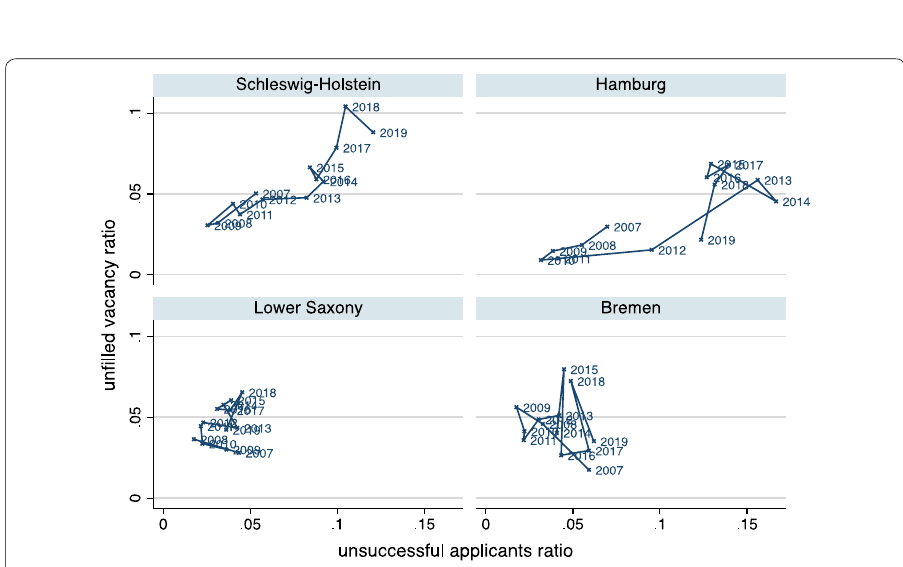
Fig. 10 Beveridge curves for North-Western German states (2007–2019). Data sources: Vocational training statistics of the statistical offices of the federal and state